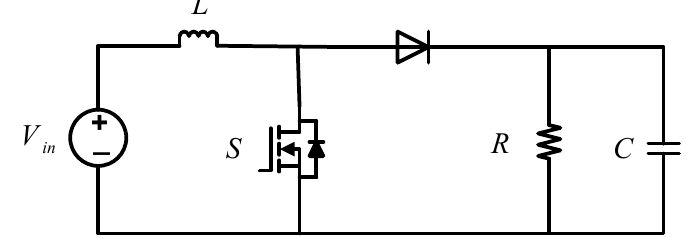
Figure 1. Boost converter .